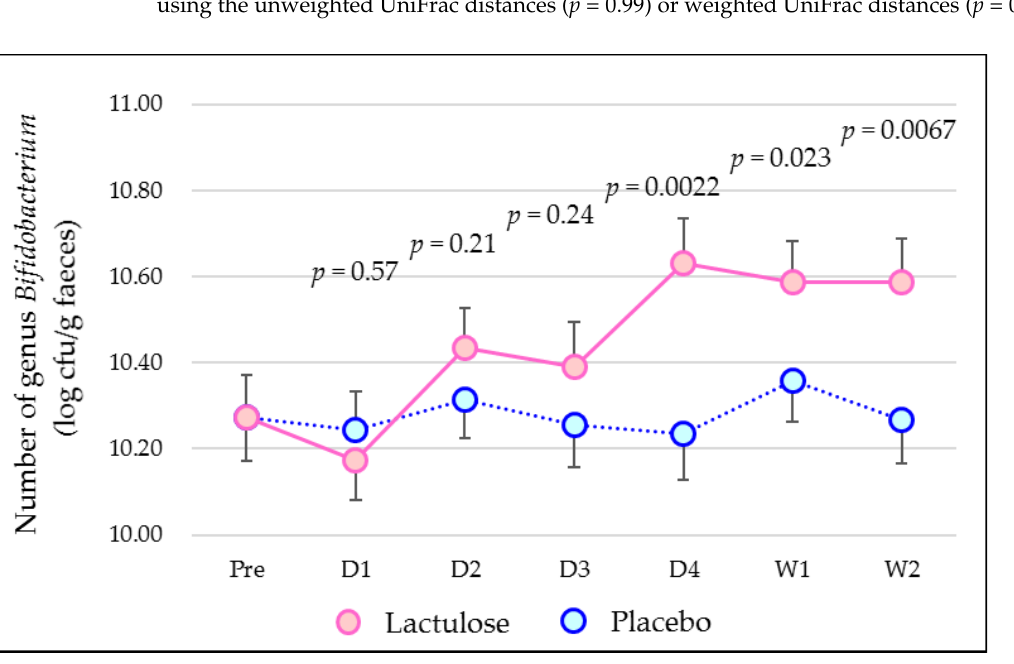
Figure A5. Cell numbers of genus Bifidobacterium in faeces. Pre means just before ingestion; D1